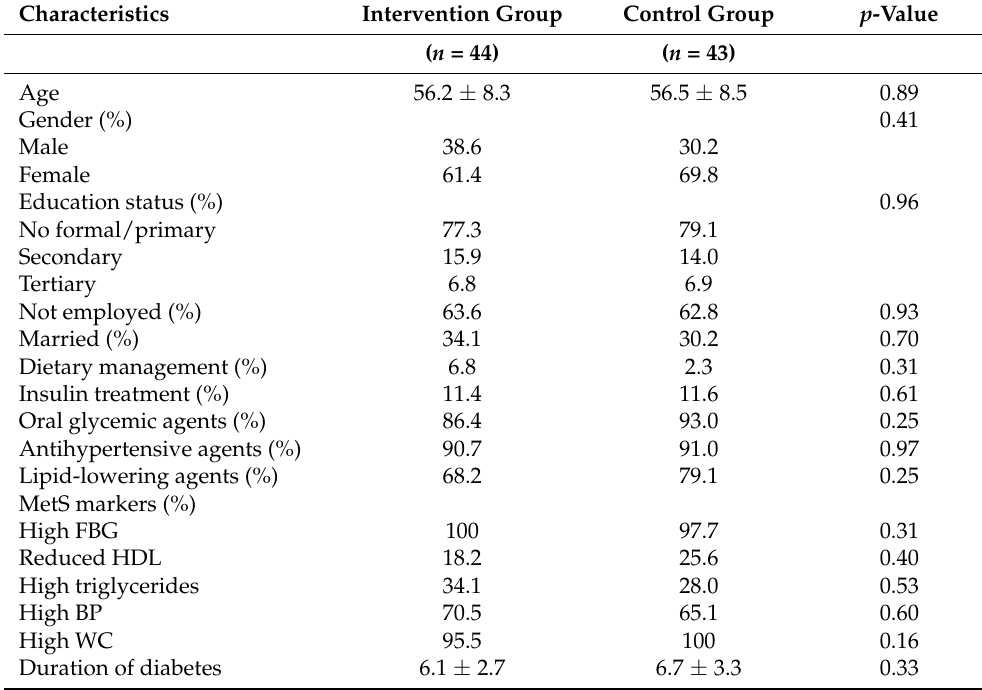
Table 1. Baseline characteristics of